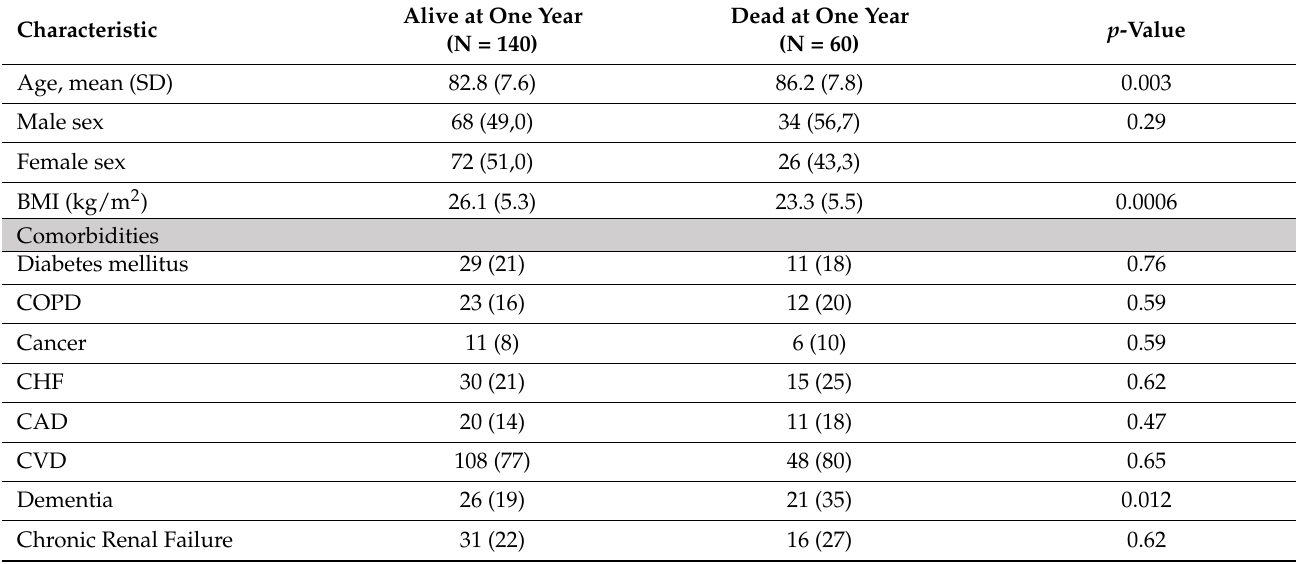
Table 1. Baseline characteristics of one-year survivors and